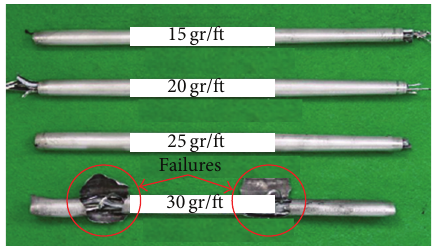
Figure 4: Experimental results of expanding